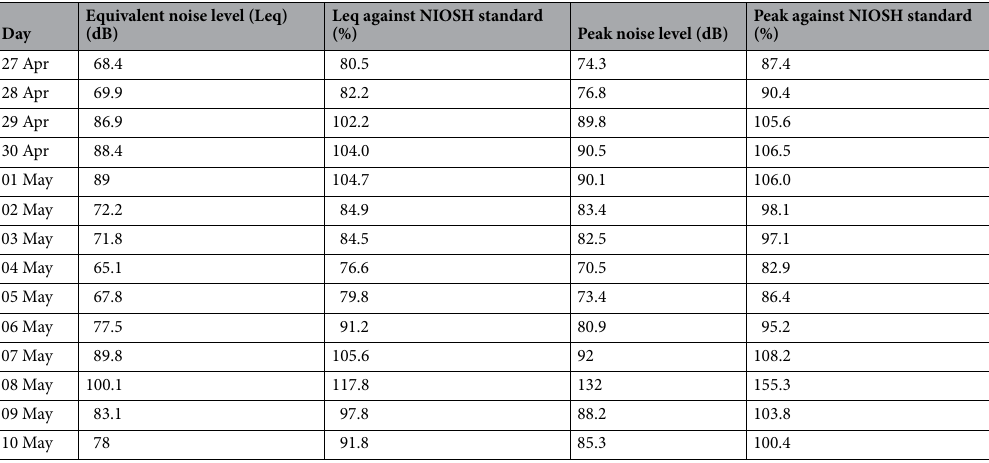
Table 7. Noise measurements recorded at Rank